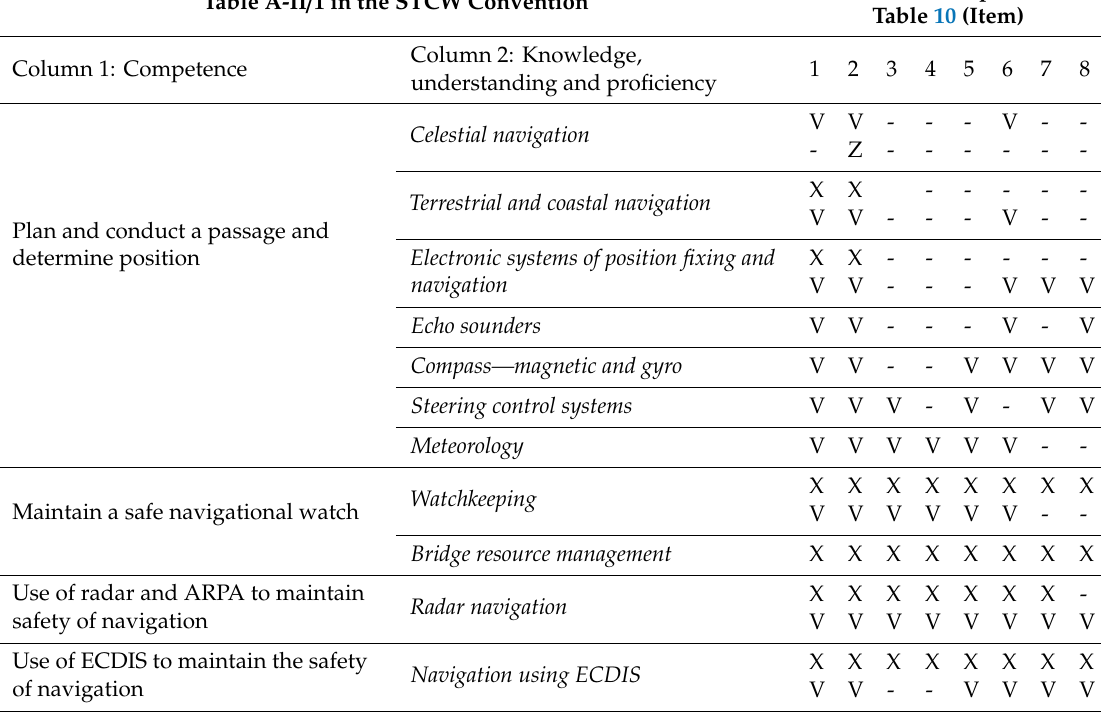
Table11. RelationshipbetweenadditionalcompetenceforROinTable10andTableA-II / 1andRegulation II / 1 in the International Convention on Standards of Training, Certification and Watchkeeping for Seafarers